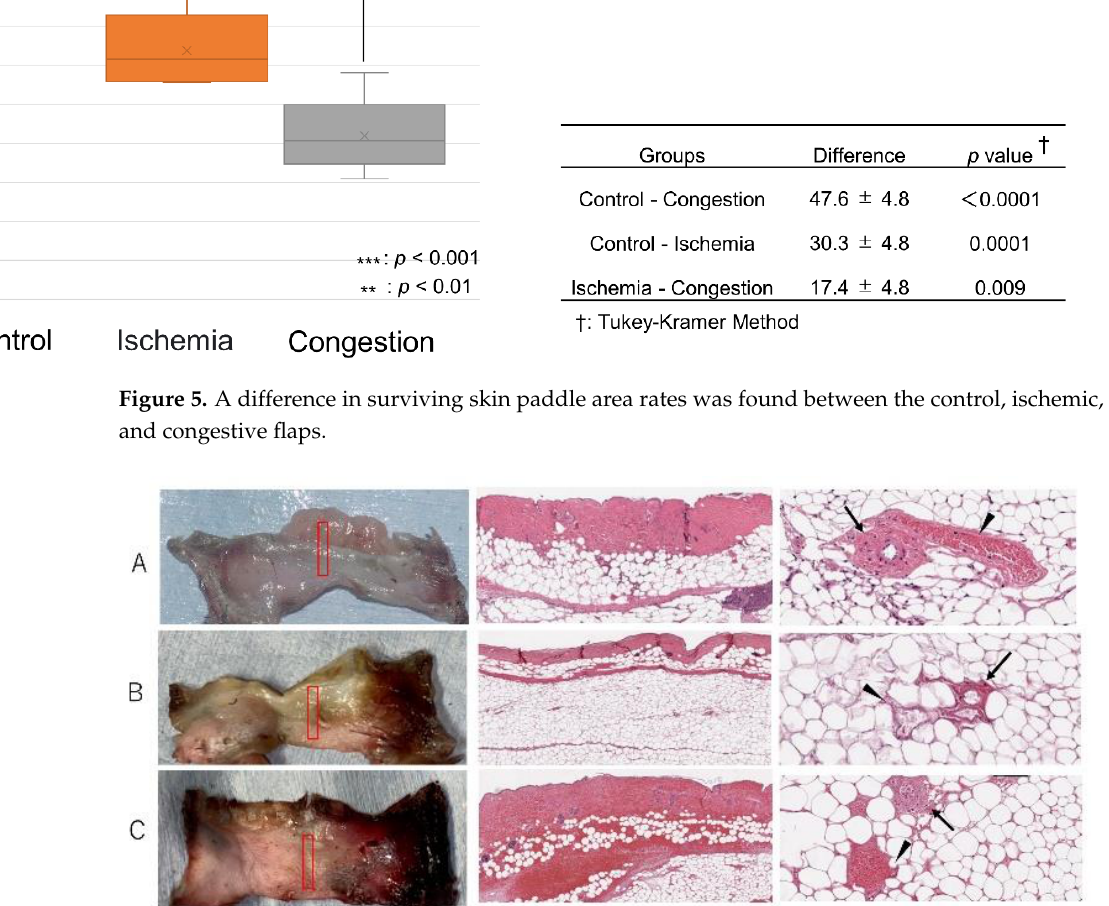
Figure 6. Histological findings in surviving skin paddle areas in the ( A ) control, ( B ) ischemic, and ( C ) congestive flaps at 72 h. The black arrow indicates an artery, whereas the black arrowhead indicates a vein. In the congestive flaps, blood cells leaked into intercellular spaces, and the vessel lumen was filled with blood.